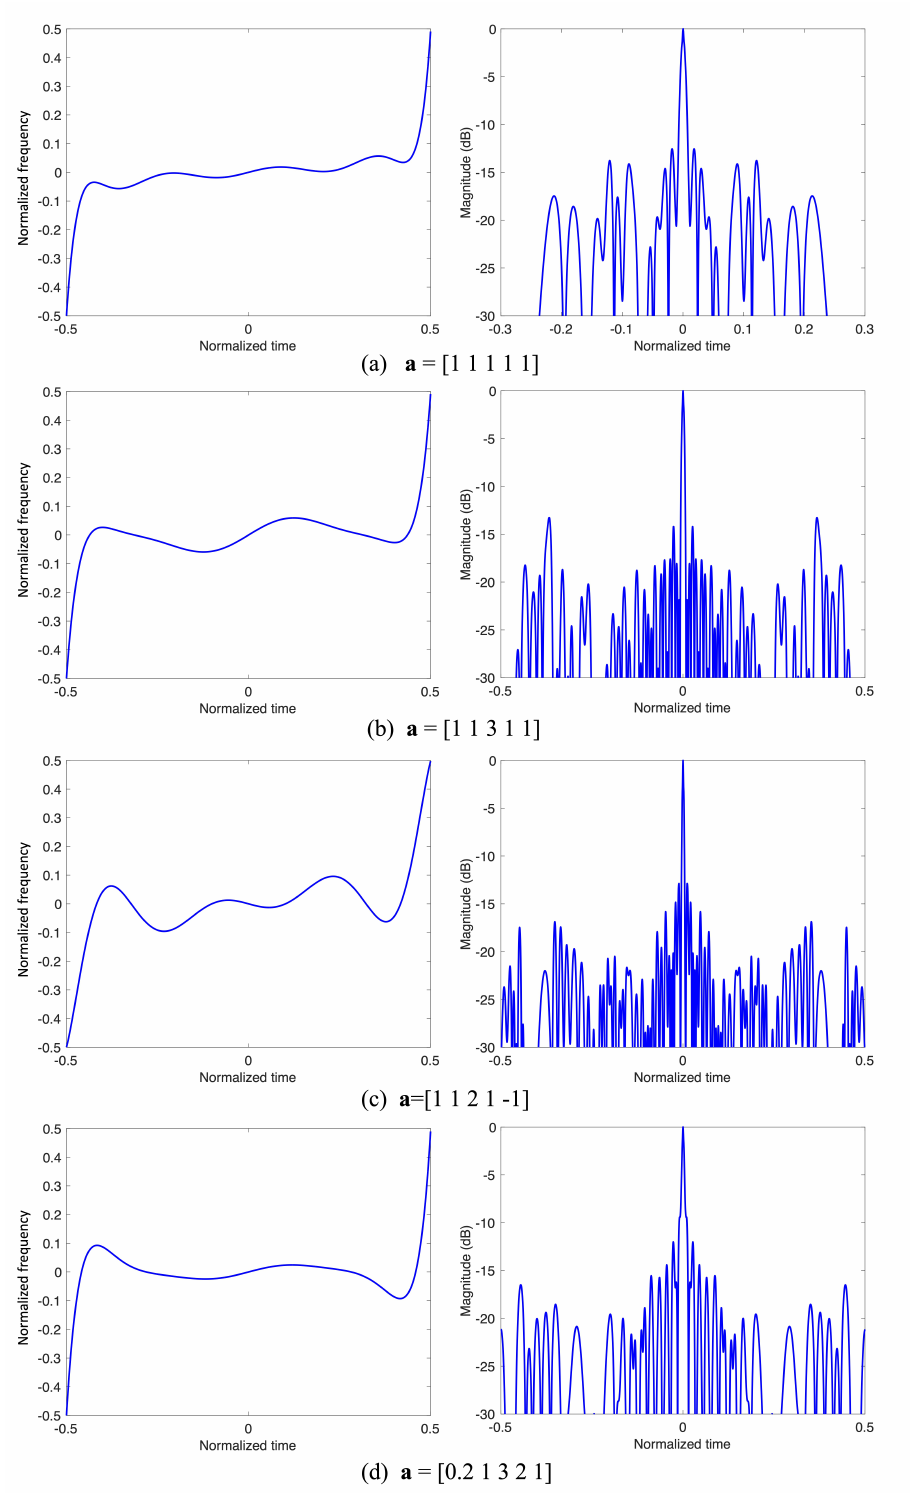
Figure 4. Modeling the NLFM signal with four coefficient vectors of LPs. The plots in the left column show the time-frequency relationship of the signal, and the right column shows the correspond- ing